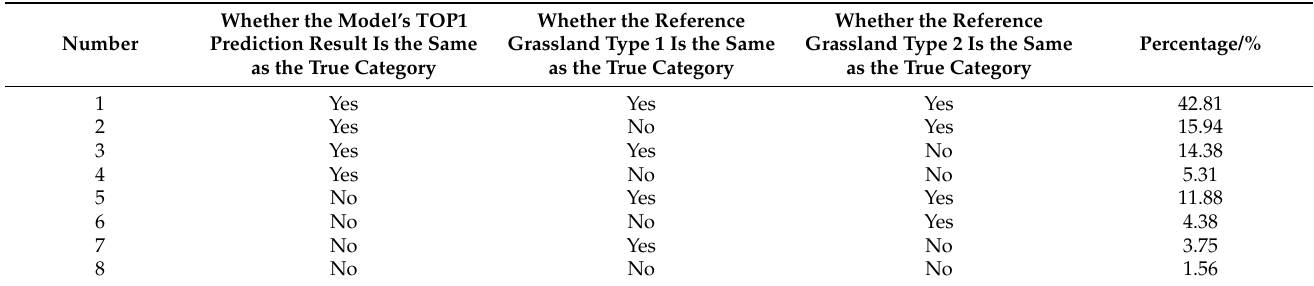
Table 4. Statistics for the system’s prediction results for grassland